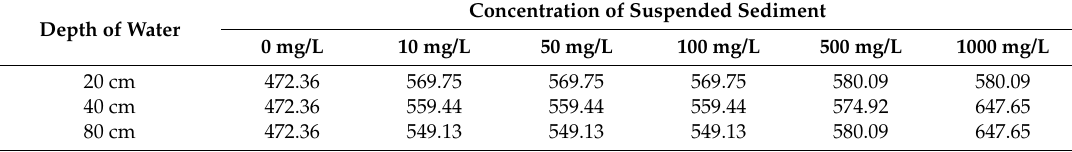
Table 1. In three different water depth conditions, statistical table of peak wavelength corresponding to the reflectance of suspended sediment in different